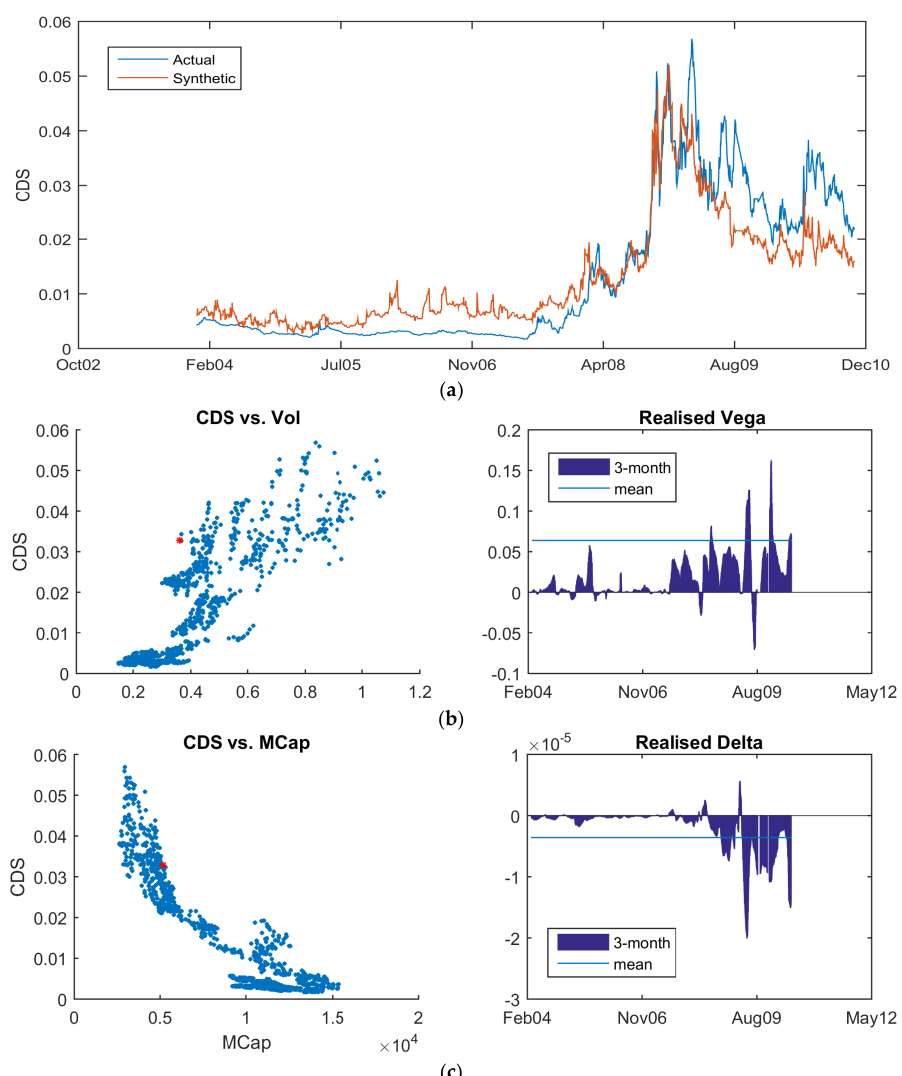
Figure 10. Peugeot SA for: ( a ) synthetic CDS vs. traded five-year CDS from January 2004 until November 2010; ( b ) scatter plot of five-year CDS versus 10-Delta implied put volatility with regressed three-month rolling hedge ratio and mean hedge ratio from June 2009; ( c ) scatter plot of five-year CDS versus market capitalization with regressed three-month rolling hedge ratio and mean hedge ratio from June 2009.